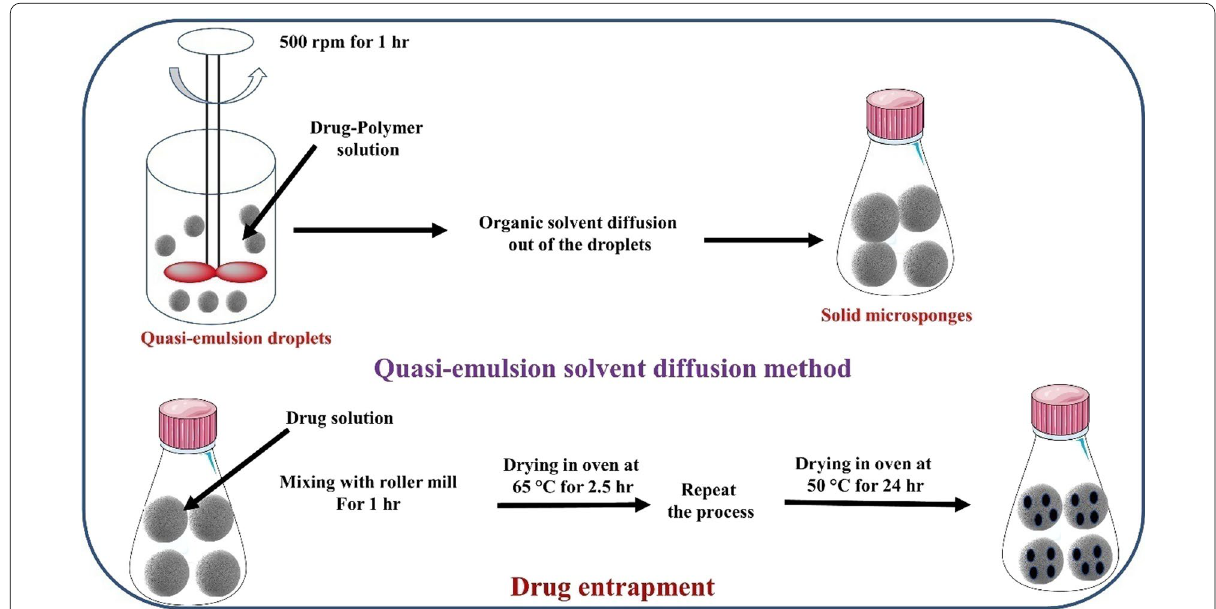
Fig. 6 Quasi-emulsion solvent